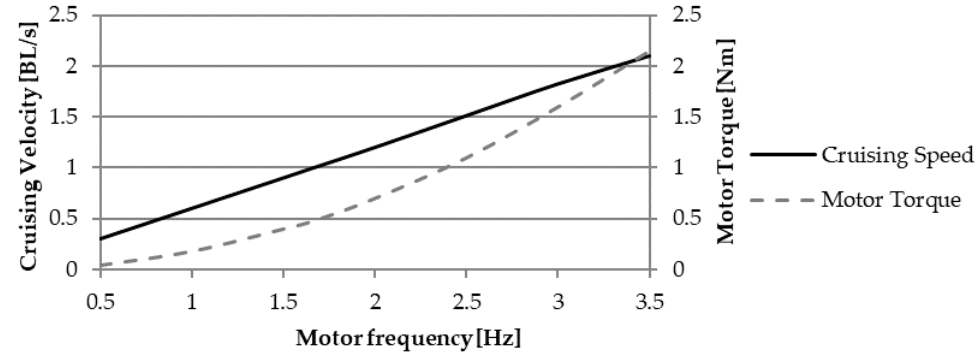
Figure 15. Average cruising speed and driving torque as a function of the motor frequency.